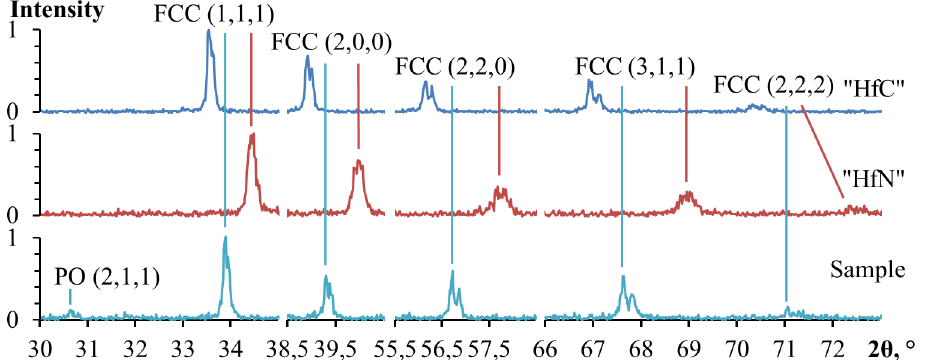
Fig 1. The XRD of powders (“HfC” and “HfN”) and the test surface of the